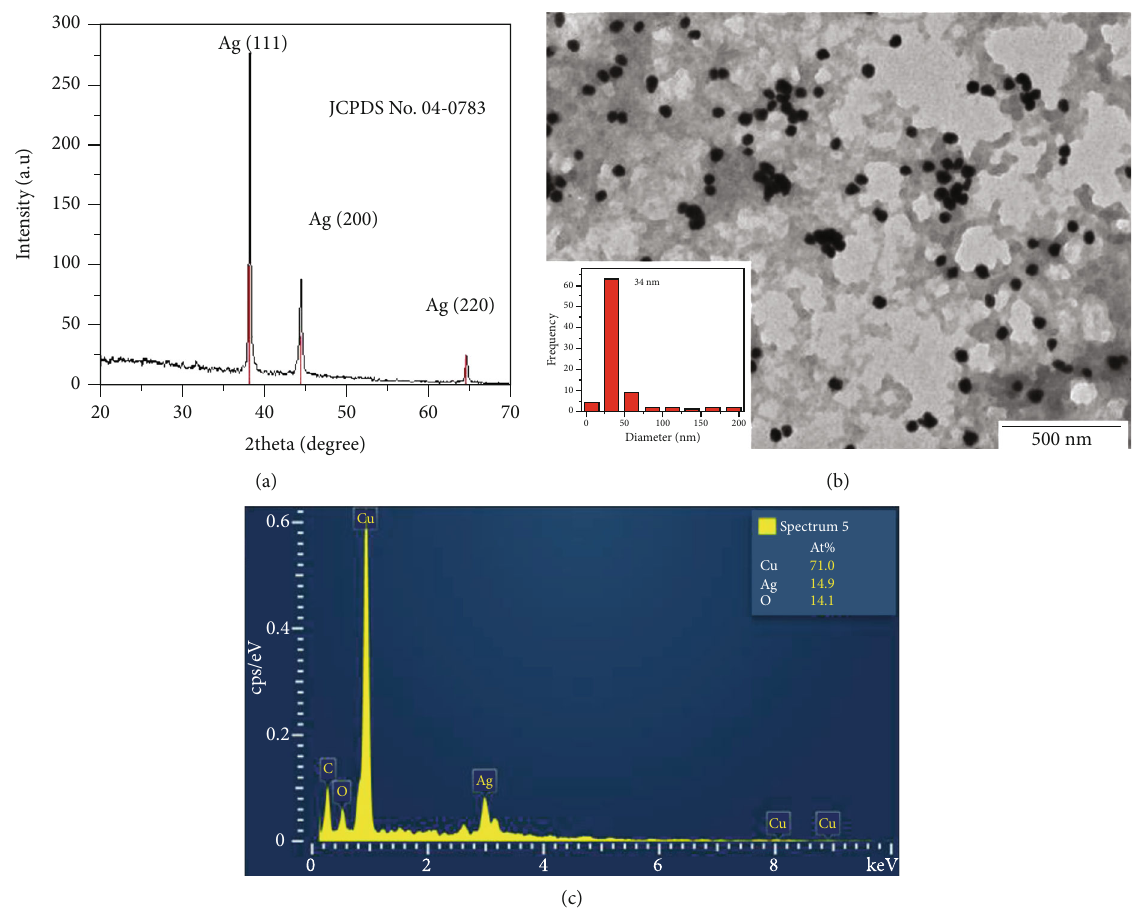
Figure 2: (a) XRD pattern, (b) TEM image, and (c) EDX spectrum of the biogenic AgNPs synthesized at